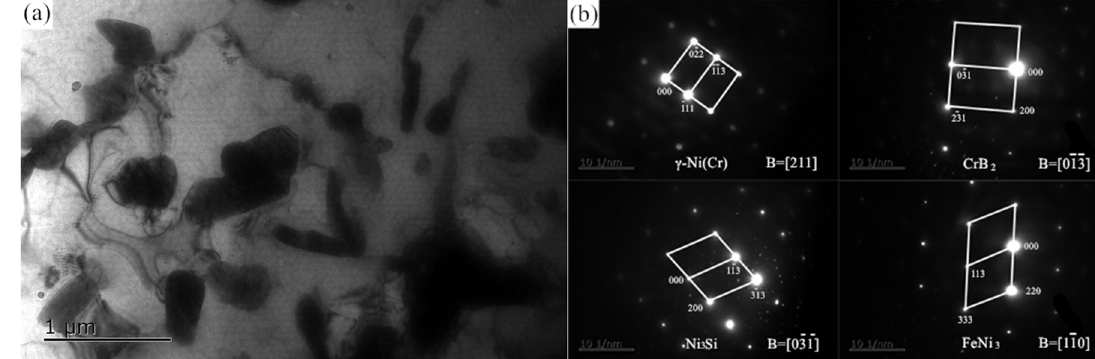
Figure 9. TEM results of DAZ.